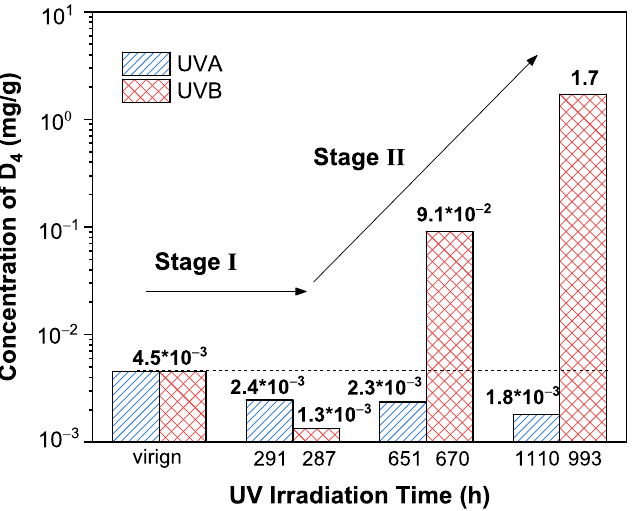
Figure 6. The calculated concentration of D 4 in virgin and UVA/UVB irradiated